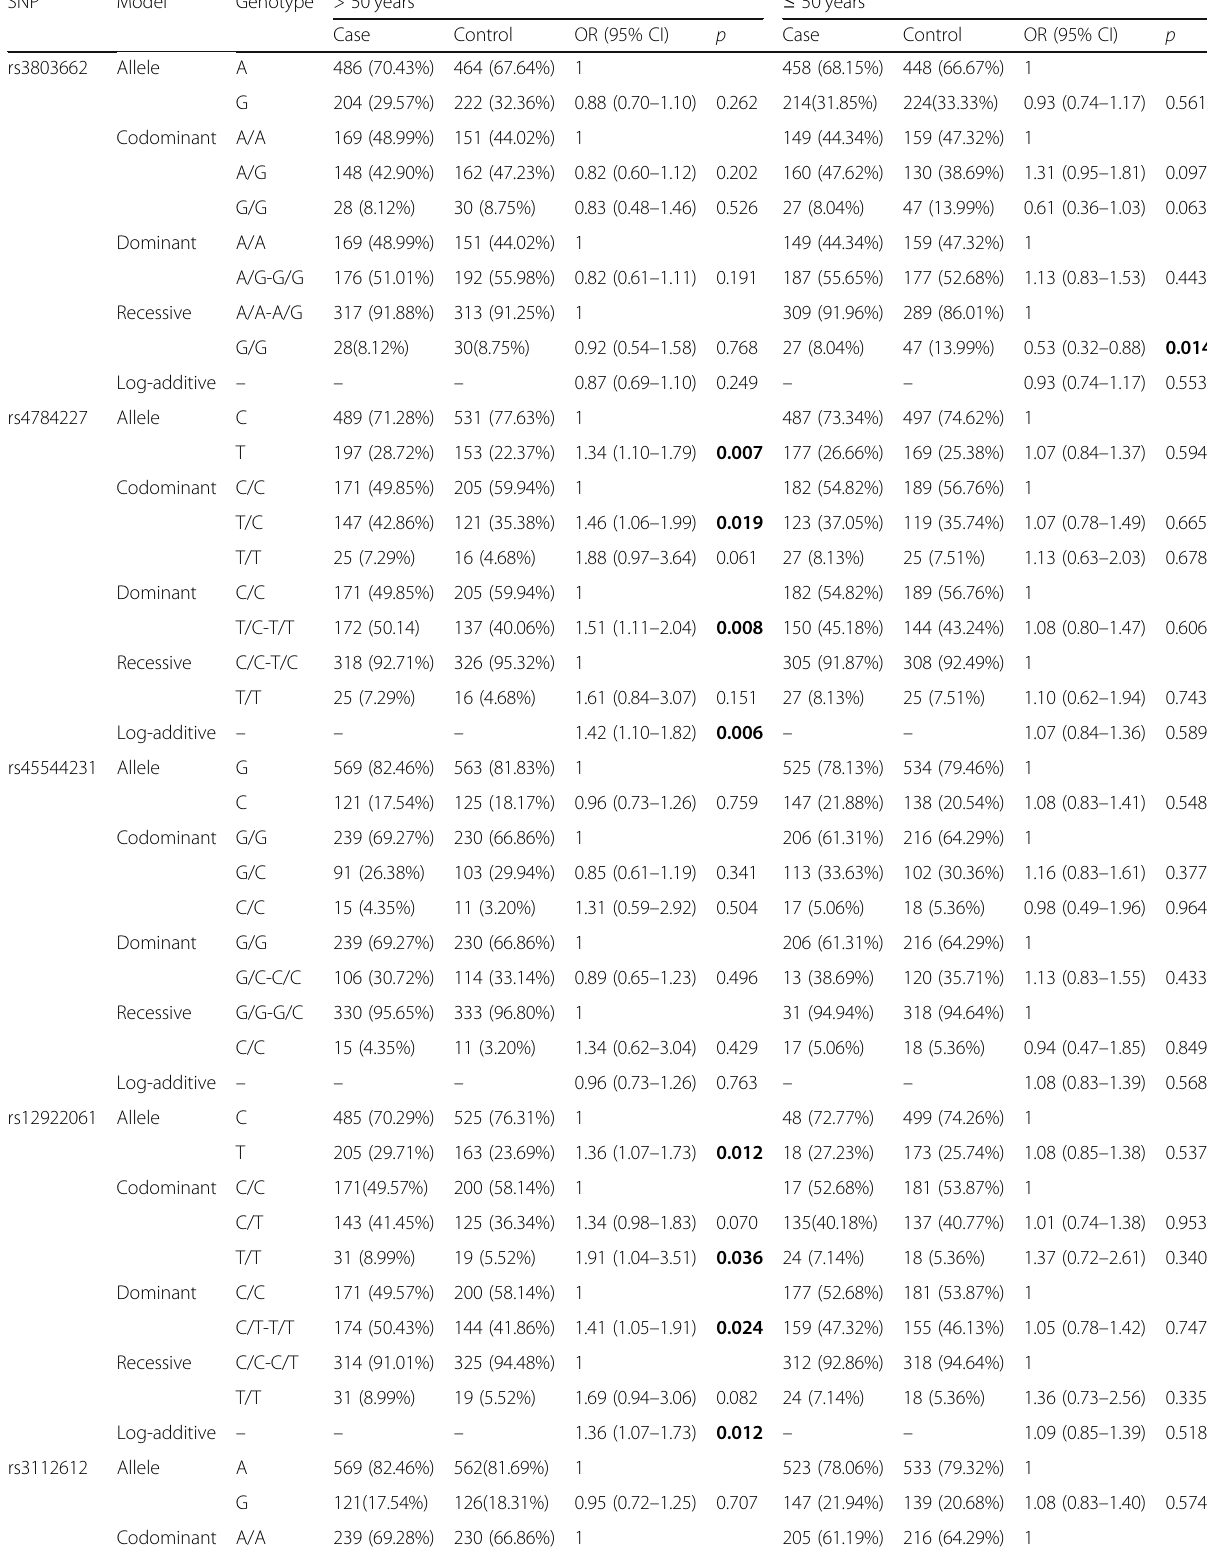
Table 4 The relationship of CASC16 polymorphisms with breast cancer according to the stratification analysis by